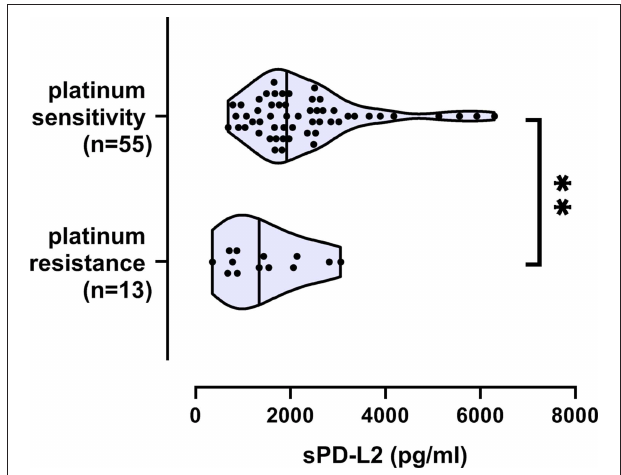
FIGURE 3 | Decreased sPD-L2 serum levels in EOC patients with platinum resistance. Straight line within the violin plot indicates the median. Platinum resistance/sensitivity was available for 68 EOC patients. ** p < 0.01.